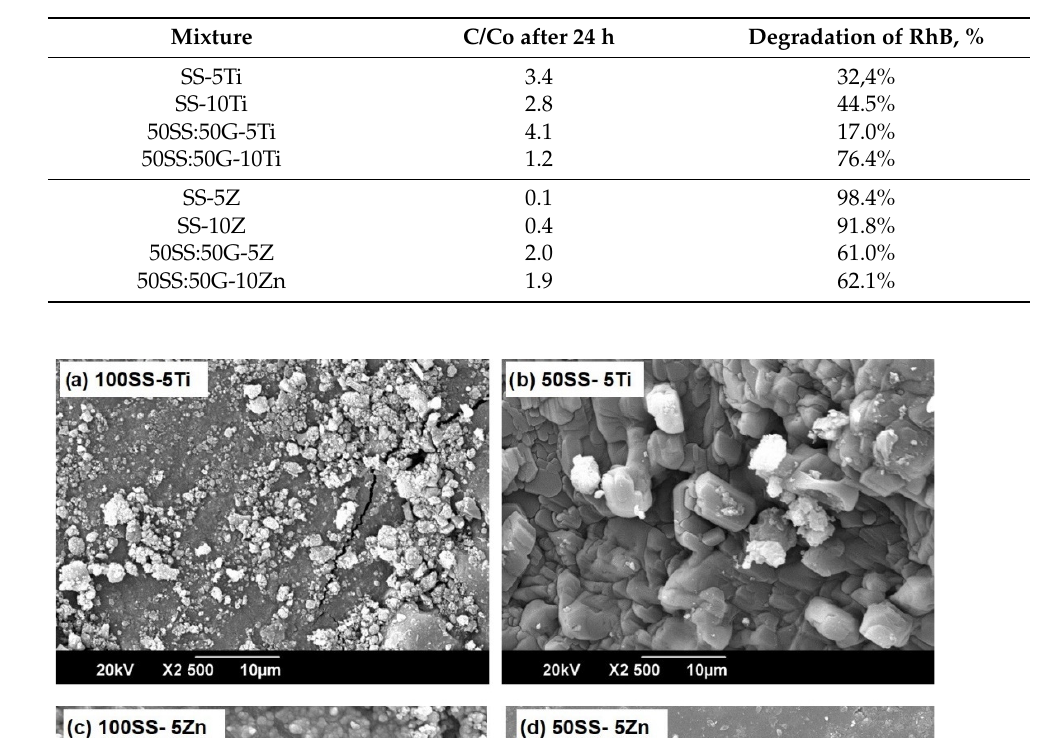
Figure 8. UV − VIS spectrum for different mixtures after 24 h of exposure to RhB with incorporations of ( a ) TiO 2 and ( b ) ZnO particles. Table 6. Percentage of degradation of Rh-B (evaluated at 554 nm) for different mixtures.